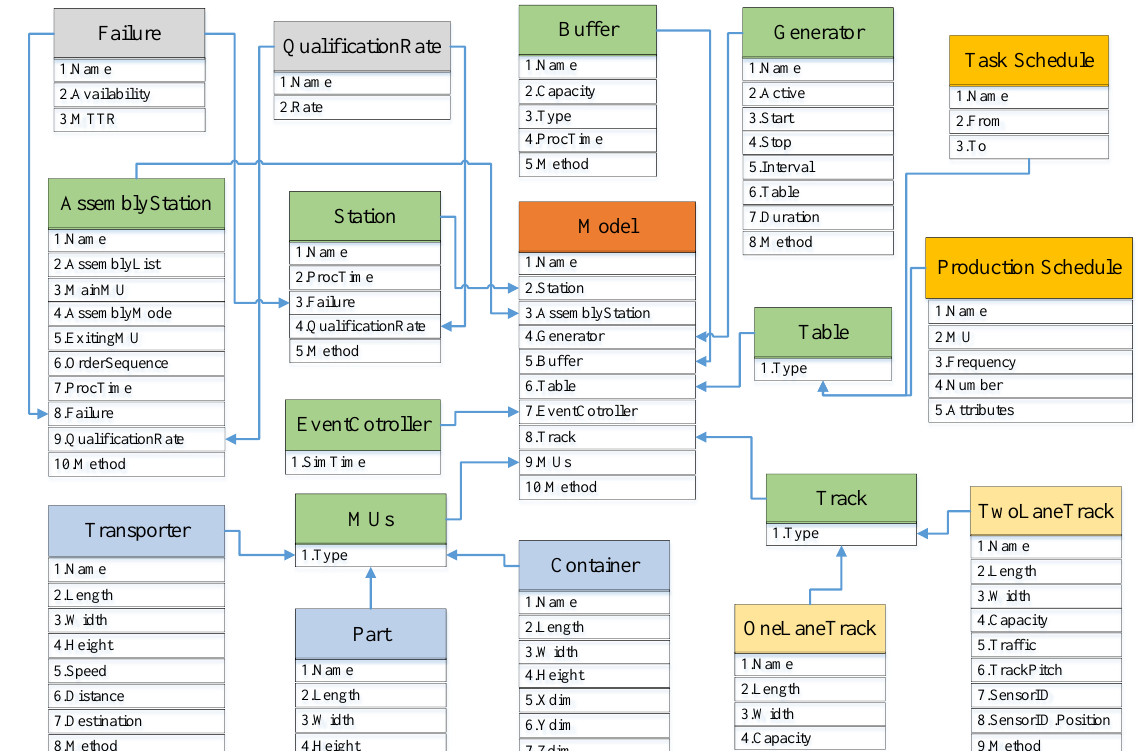
Figure 12. Data model of the assembly line in digital twin system.